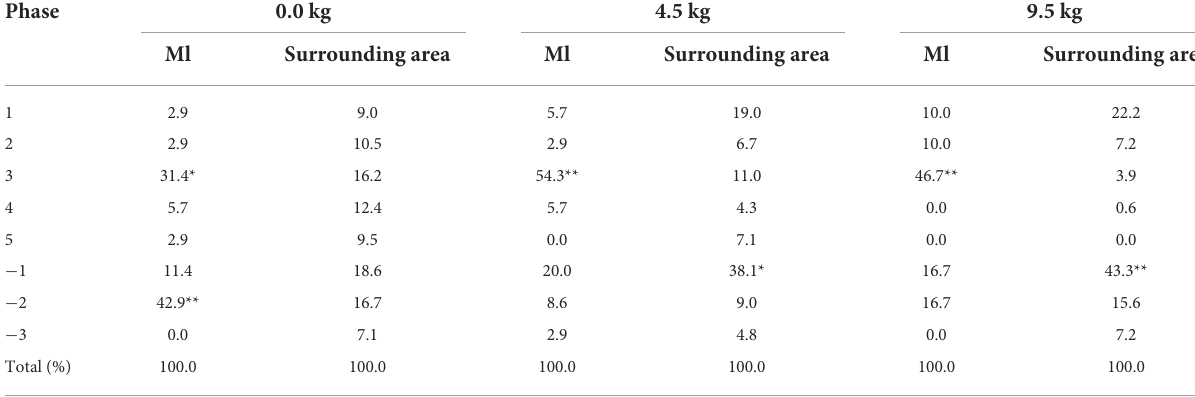
TABLE 1 Phase distribution (%) of the CORE vectors during the tasks.